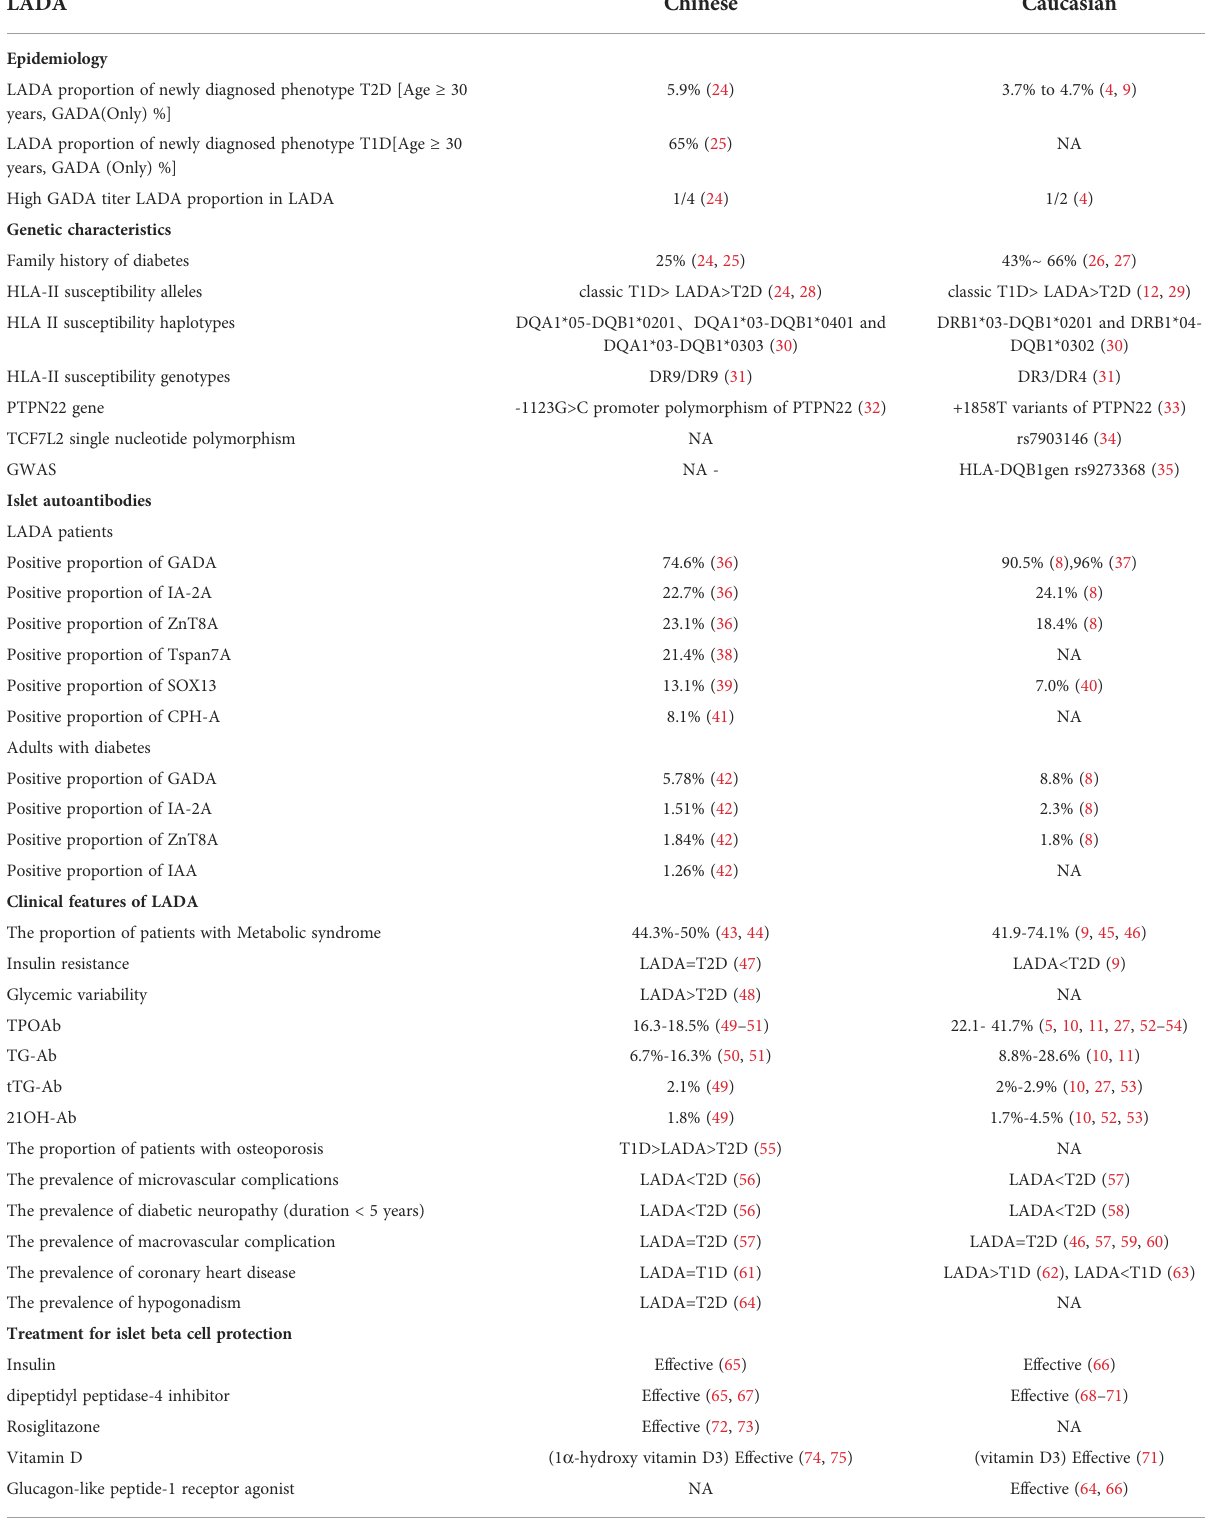
TABLE 1 Comparison of latent autoimmune diabetes in adults between Chinese and Caucasian